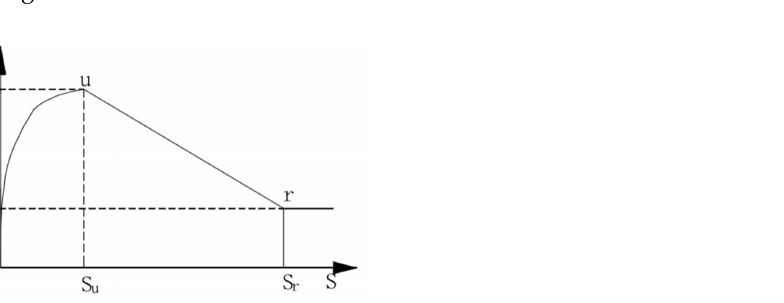
Figure 12. Bond–slip constitutive diagram for reinforced concrete under monotonic load after freeze–thaw cycles. Ascending stage: